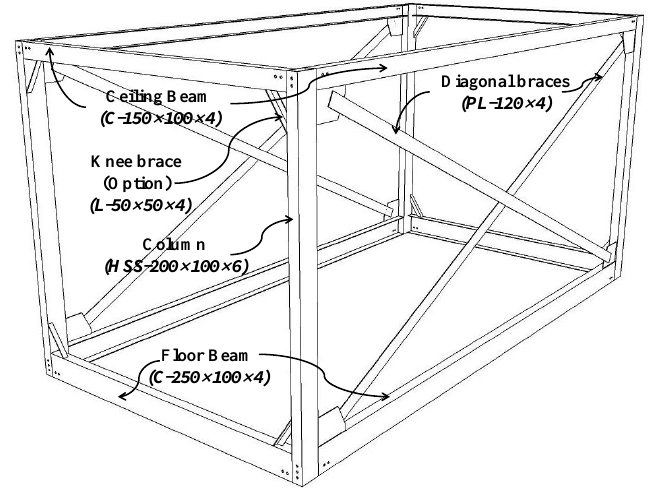
Figure 1. Modular unit composition.